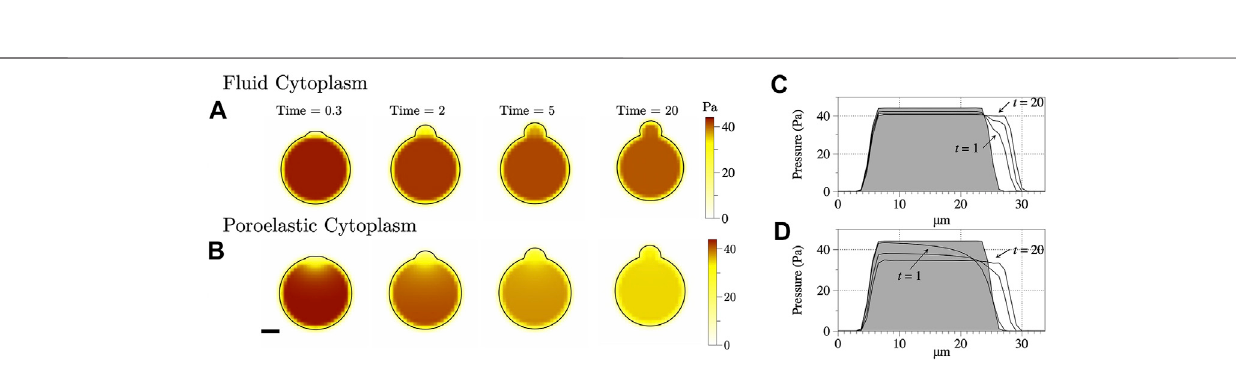
FIGURE4|(A – B) Intracellularpressureinthe xz -plane( y (cid:1) 15)forthesimulationsfrom Figure3 .Thescalebardenotes5 μ m. (C – D) Pressurealongtheline z (cid:1) 0to 30 for x , y (cid:1) 15. The intermediate time denotes pressure at t (cid:1) 2